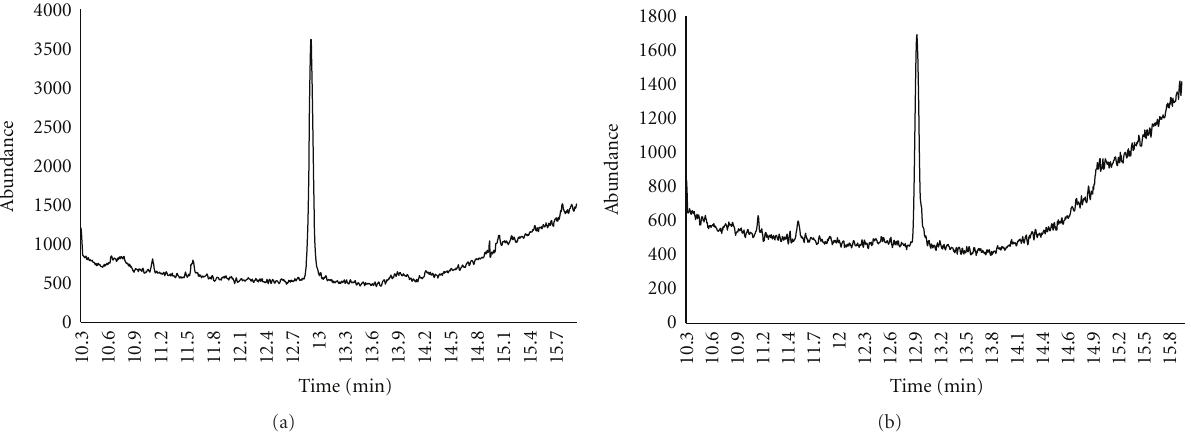
Figure 3: Chromatogram obtained after spiking hair with 5ng Δ 9 -THC and digesting it with (a) Proteinase K and (b)